Question: Describe this figure in one sentence.
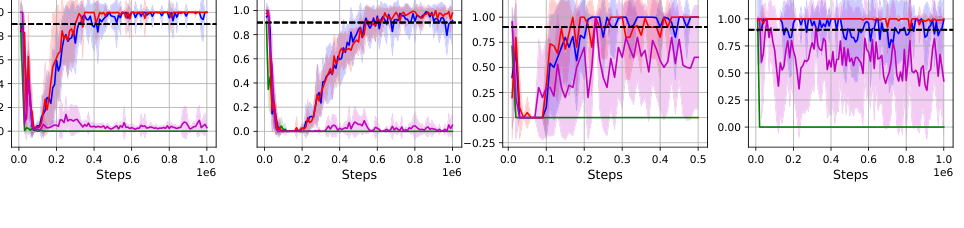
Answer: Safety Bullet Gym Experiments - Reward and Safety Performance